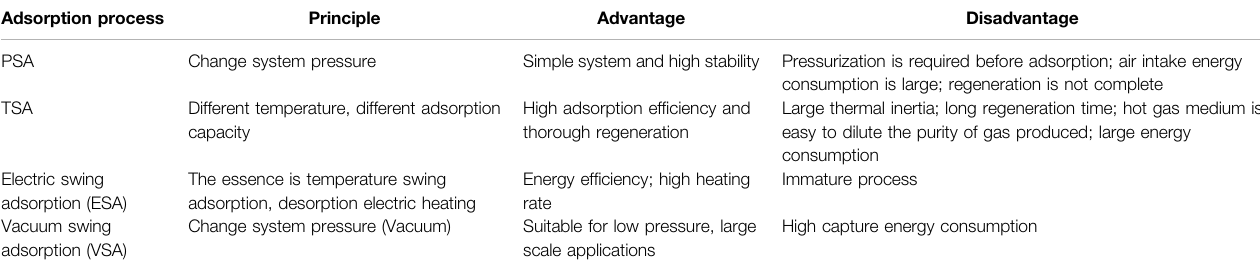
TABLE 1 | Common adsorption carbon capture